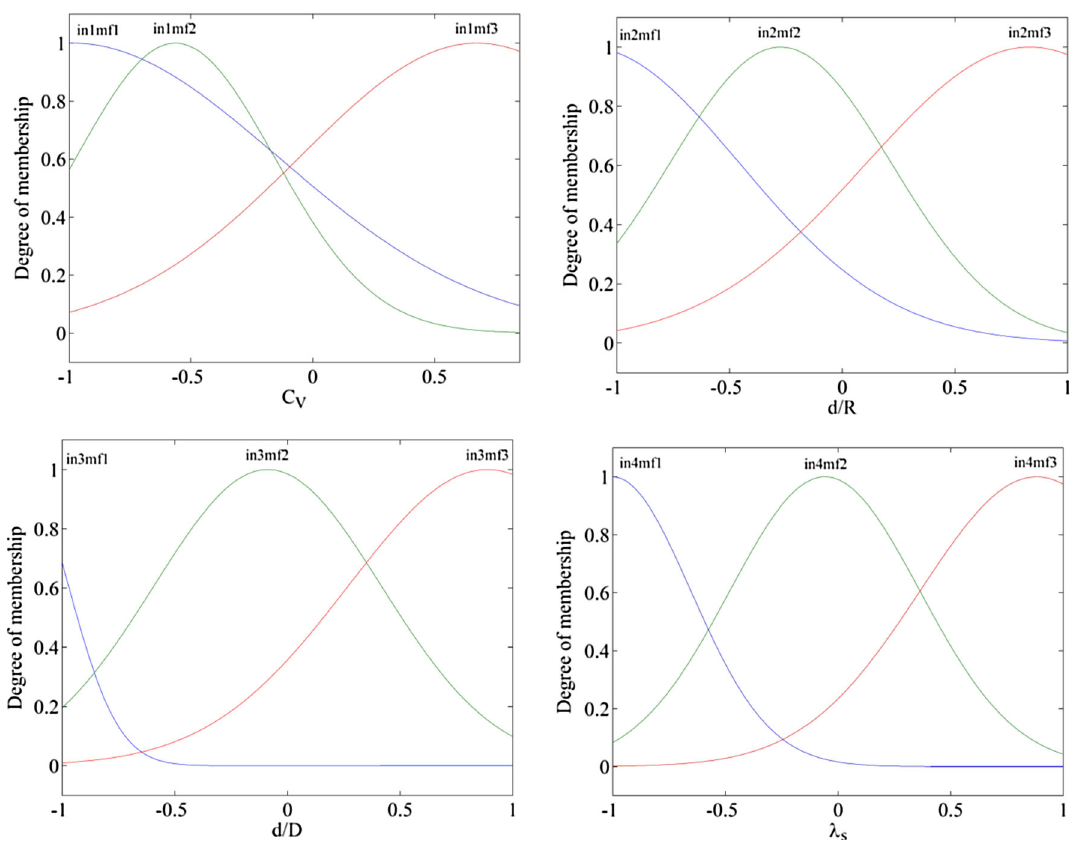
Fig. 2 Fuzzy membership functions for the input